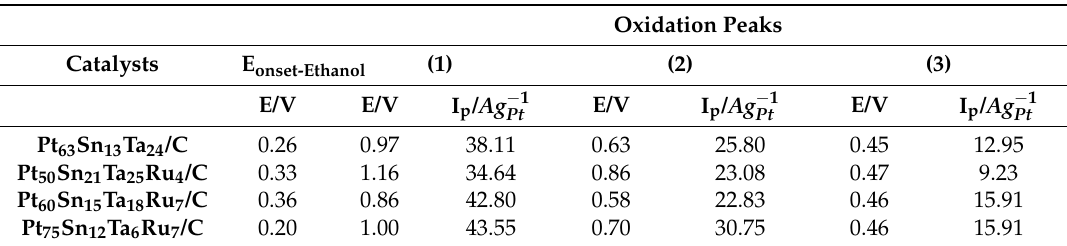
Table 2. Currents and potentials of the oxidation peaks for the PtSn/C-type catalysts modified with Ta and